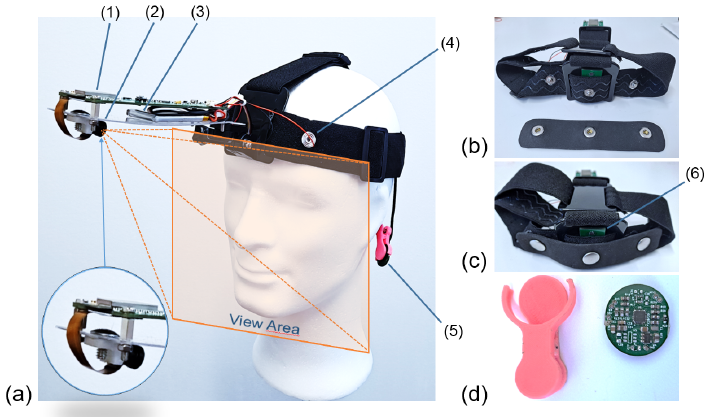
Figure 1. Final design of the platform and fastening system. ( a ) Side view of the platform. ( b ) Elec- trodes of the EDA/bioimpedance subsystem. ( c ) View with the electrodes placed in their final position and fixed by means of the EVA foam. ( d ) PCB with SpO2 and HR measure systems and fastening system in pink. (1) Microcontroller, (2) camera, (3) LIPO battery, (4) EDA electrode, (5) pulse oximeter, (6) temperature sensor.